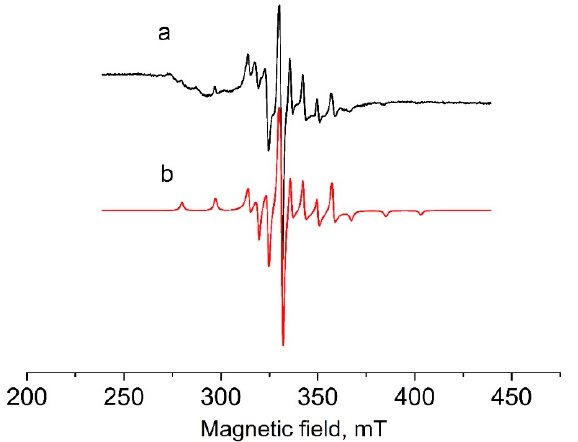
Figure 2. EPR spectra of solution of 2 in dichloromethane at 77 K. Black—experimental, red—simulated.